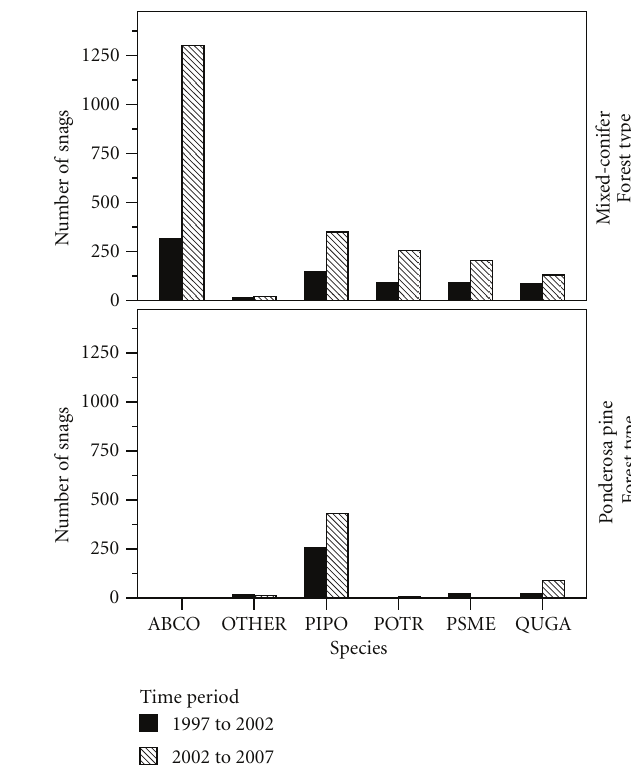
Figure 8: Number of snags recruited by snag species in northern Arizona mixed-conifer and ponderosa pine forest from 1997 to 2002 and from 2002 to 2007. Species acronyms: ABCO: white fir, PIPO: ponderosa pine, POTR: quaking aspen, PSME: Douglas-fir, QUGA: Gambel oak, and OTHER: all other species. Recruitment occurred in all species and increased for most species between 2002 and 2007 but was especially pronounced for white fir in mixed-conifer